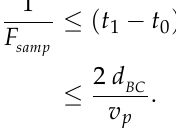
Figure 6. A Simple daisy chain connection with three